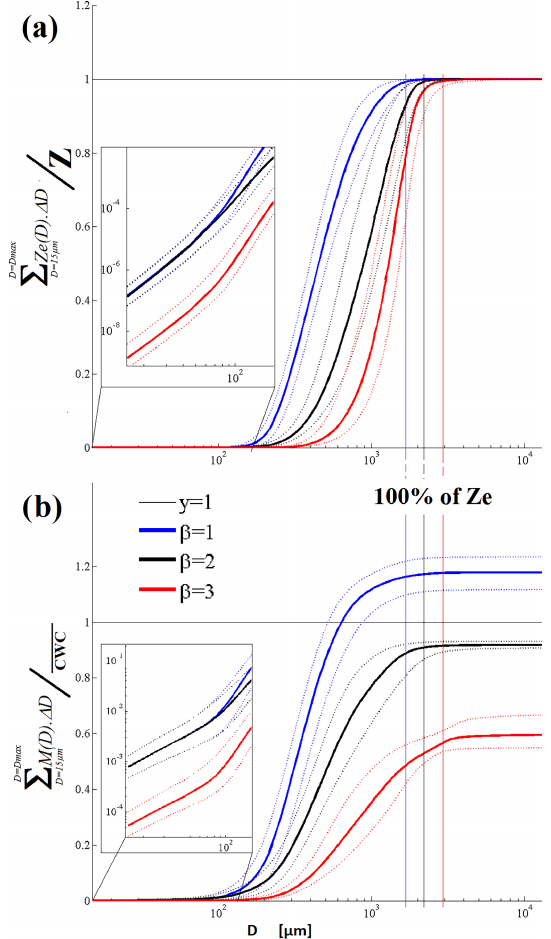
Figure 2. (a) Ratio of cumulative sum of simulated Ze over mea- sured total Z as a function of D max for three chosen ( α i ,β i ) solu- tions ( β = 1, 2, and 3). (b) Ratio of the cumulative sum of ice crystal mass over the CWC for constant β ( β = 1, 2, and 3), represented as a function of D max . Full lines represent median and dashed lines 25th and 75th percentiles for entire dataset with blue lines for β = 1, black lines for β = 2, and red lines for β = 3.